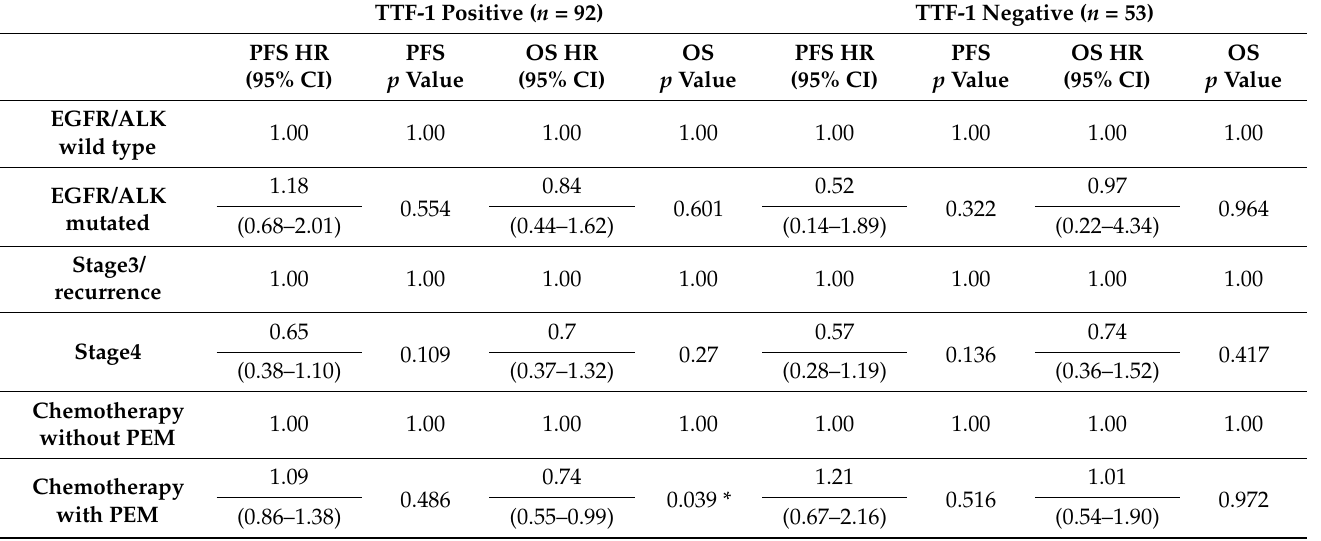
Table 3. Multivariable analysis of PFS and OS in patients who were TTF-1-positive and patients who were